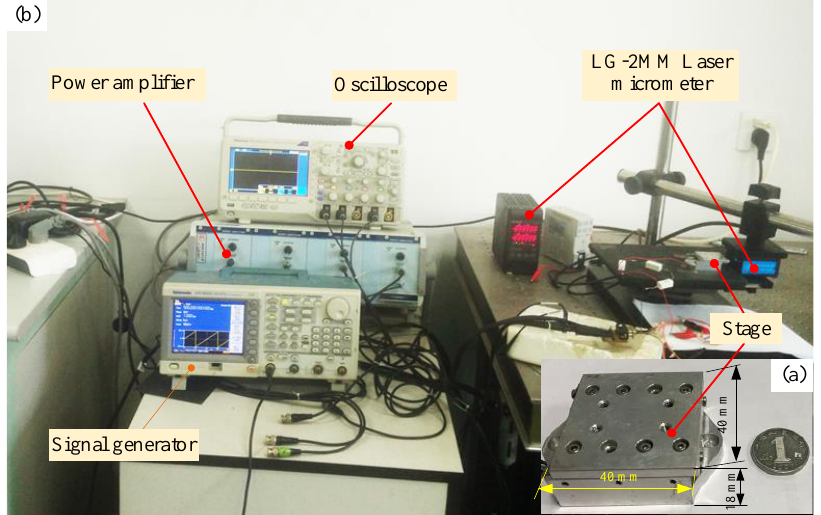
Figure 8. Prototype of the stage and its measurement setup. ( a ) Prototype of the stage. ( b ) Measurement setup.